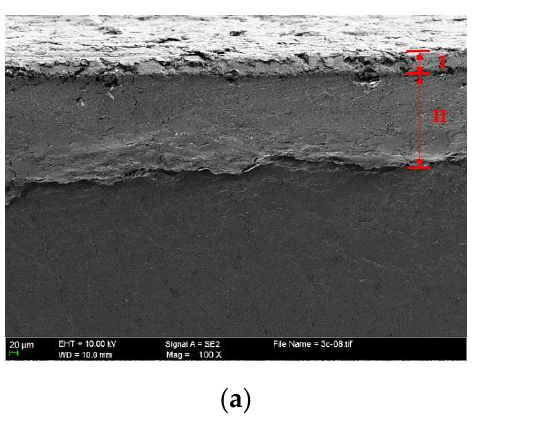
( c ) Figure 12. Scuffed piston ring surface and elemental content of CKS/Fe. ( a ) SEM image; ( b ) EDS spectrum g; ( c ) EDS spectrum h